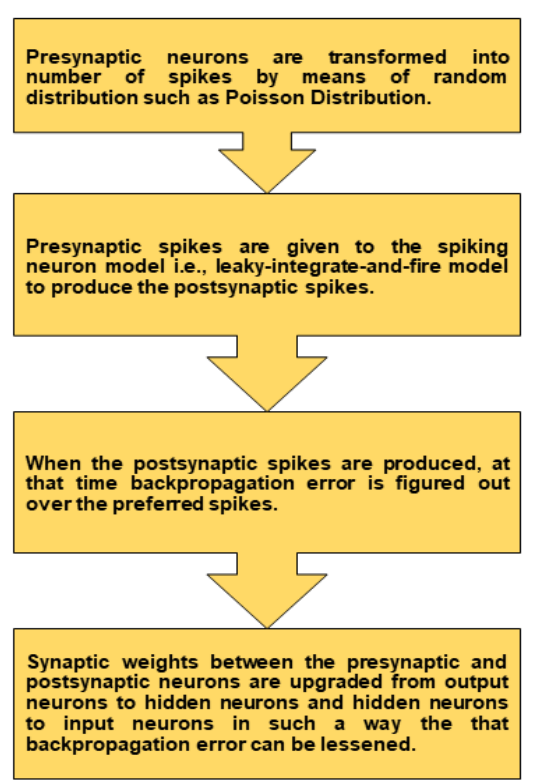
Figure 4. Flow diagram of the training